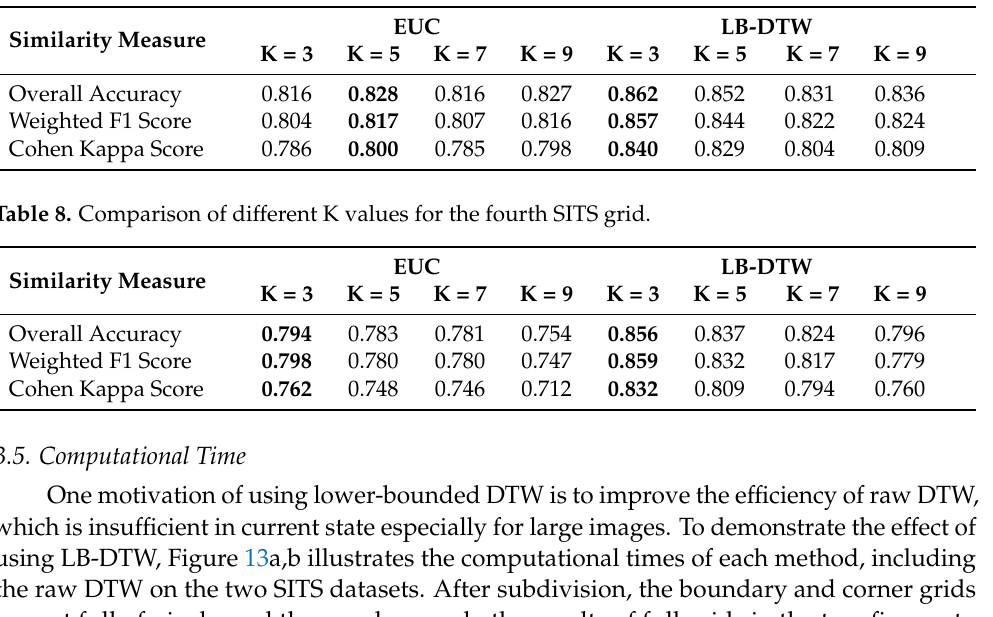
Table 7. Comparison of different K values for the third SITS grid.